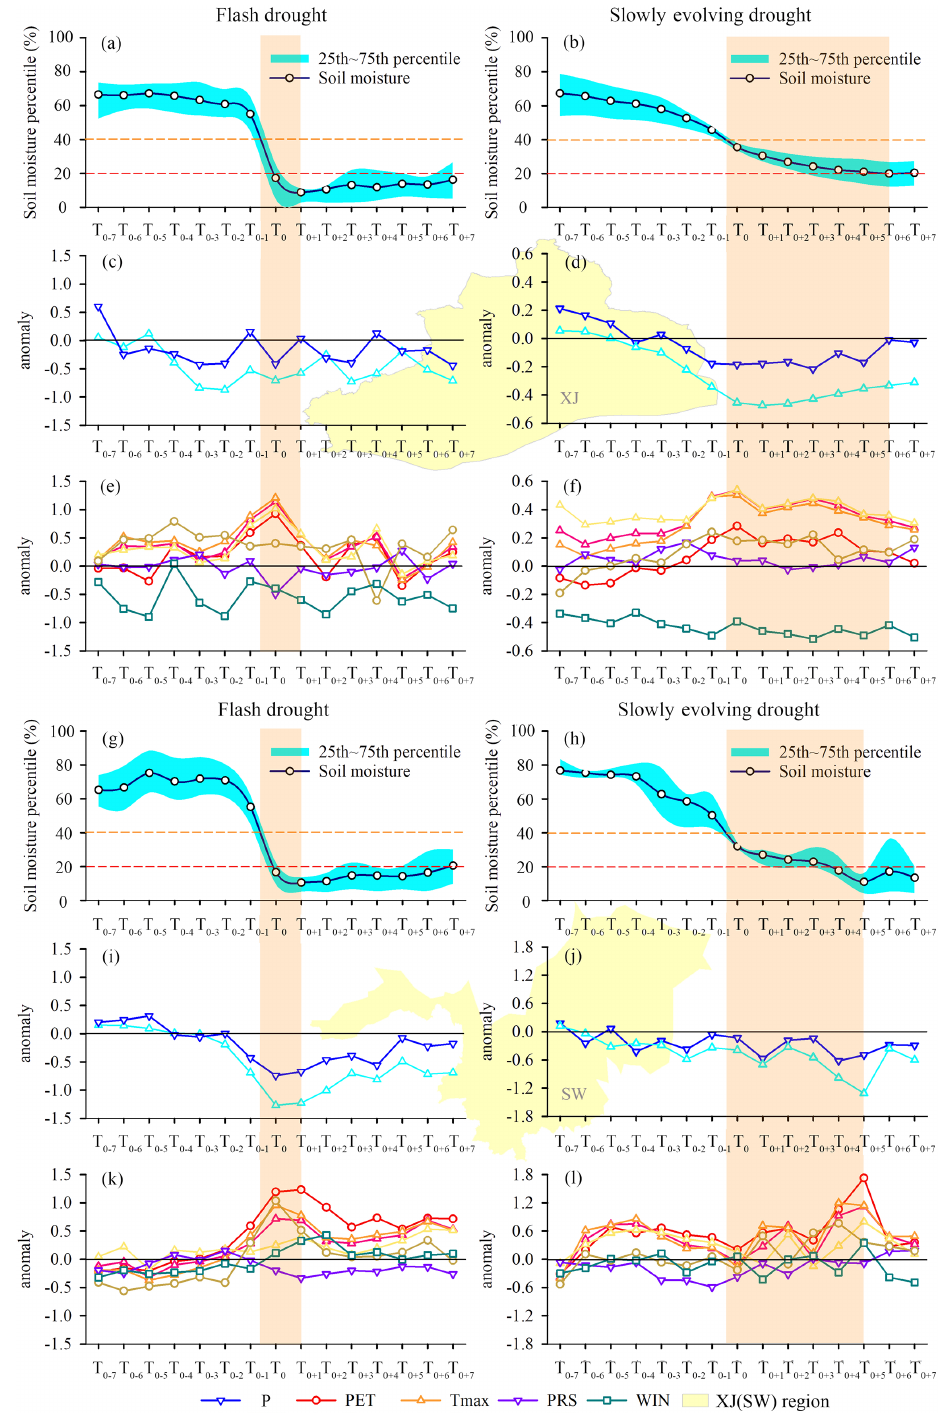
Figure 11. Time series of weekly soil moisture percentile and moisture-related (i.e., P and RHU) and energy-related (i.e., PET, T mean , T max , T min , PRS, SSD, and WIN) climate factors in the adjacent week ( T 0 − 7 – T 0 + 7 ) to drought onset during 1979–2016 for flash droughts and slowly developing droughts in the XJ and SW regions. The blue shading (Fig. 11a, b, g, and h) denotes the 25th–75th percentile range of soil moisture values. The orange shading in all 12 panels represent the onset–development phase of